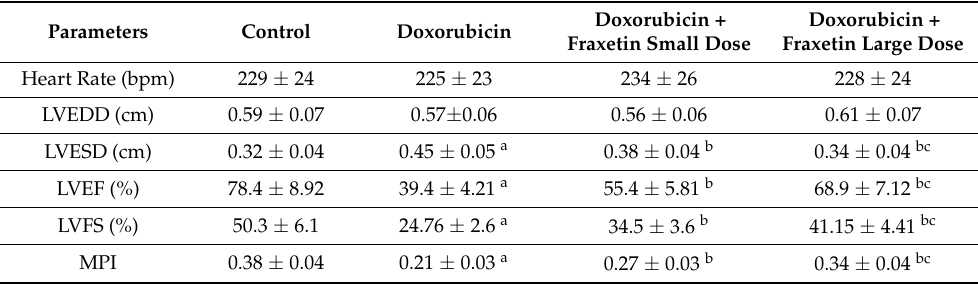
Table 3. Effect of different doses of fraxetin on the echocardiographic indices in doxorubicin-treated rats (Mean ±